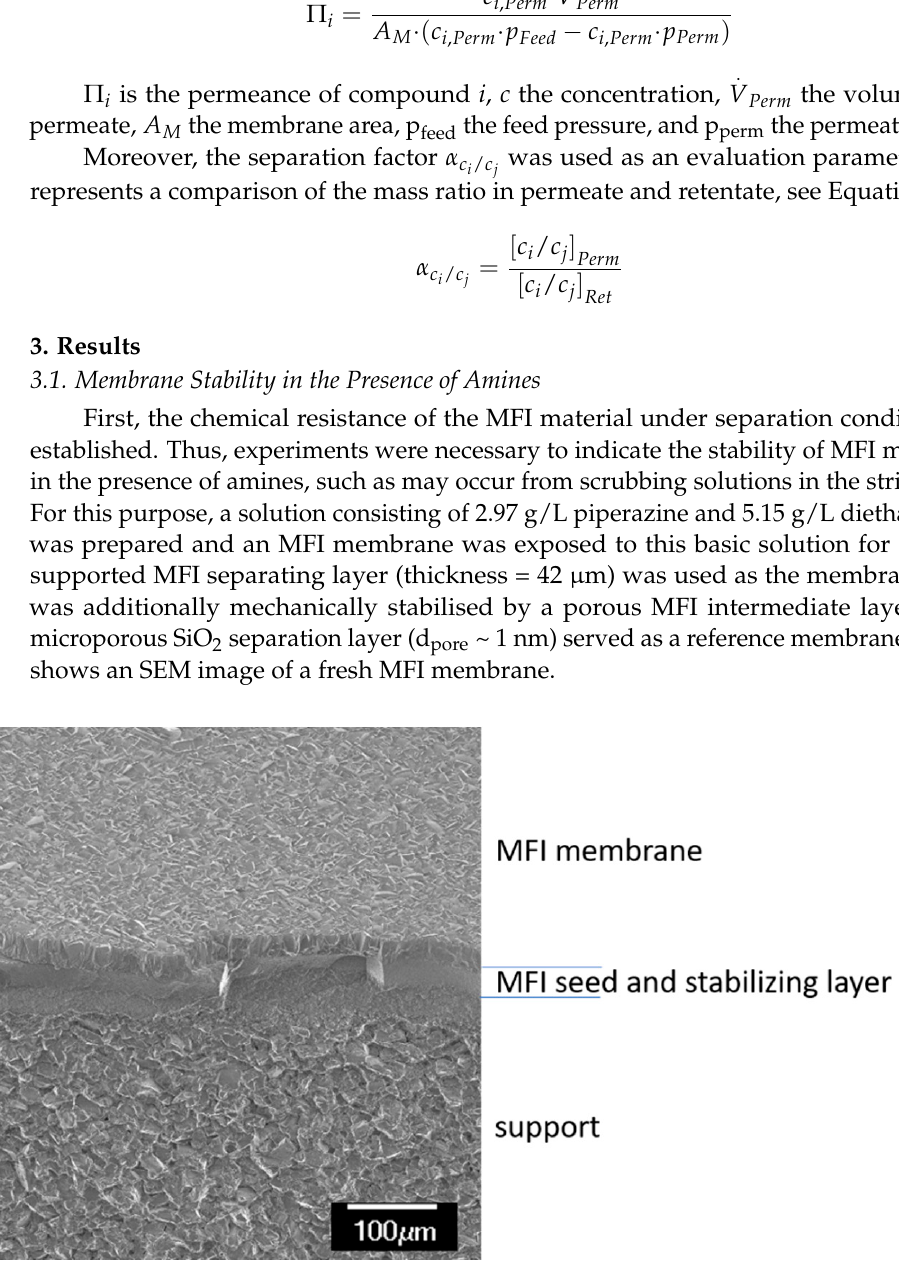
Figure 2. SEM micrograph of a fracture of a fresh MFI membrane.